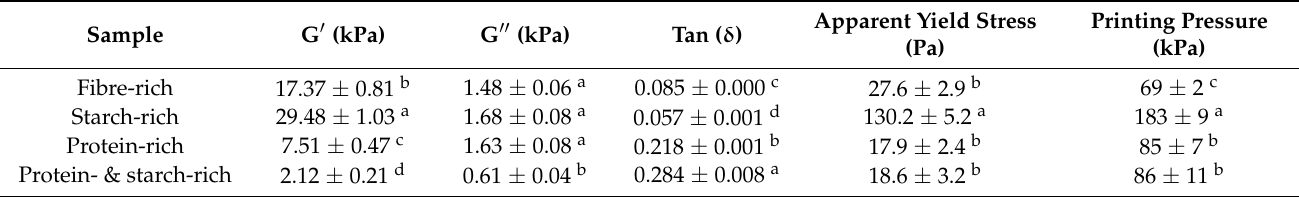
Table 3. Results of stress sweep measurements and printing pressure for each ink. The storage modulus (G (cid:48) ), loss modulus (G (cid:48)(cid:48) ) and tan( δ ) values were calculated as averages over the linear